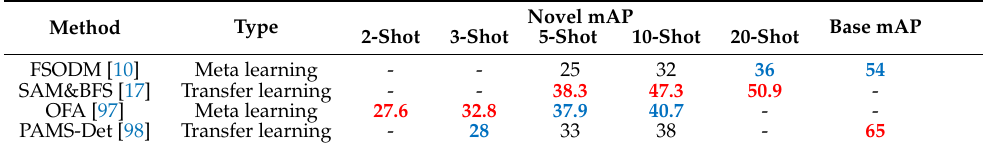
Table 5. FSOD performance (AP50 in %) on the base and novel classes of the DIOR dataset. Novel classes are airplane, baseball field, tennis court, train station and windmill. Red and blue in dicate the SOTA and the second best, respectively.